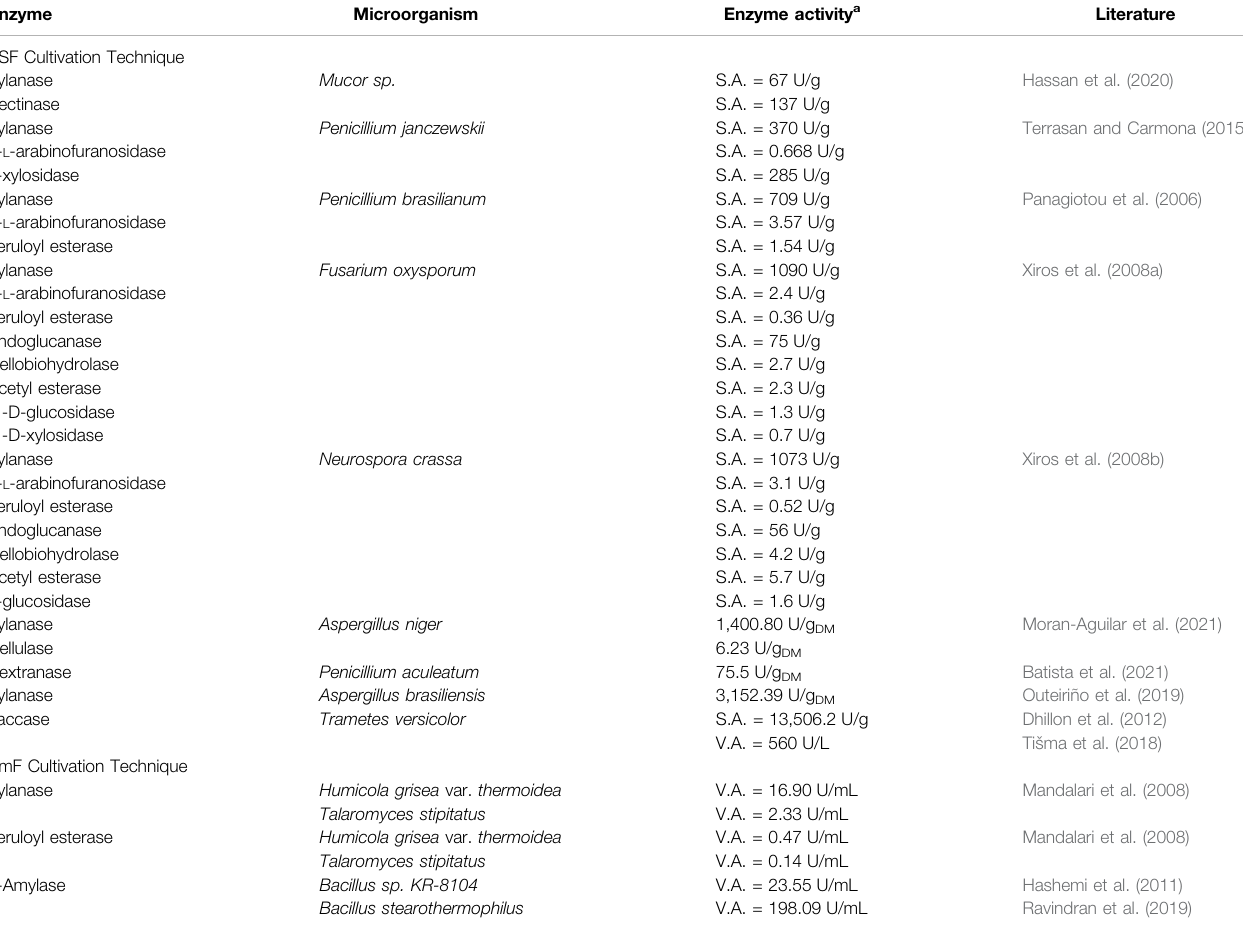
TABLE 3 | BSG as a substrate for the production of different enzymes by different microorganisms in SSF or SmF conditions.